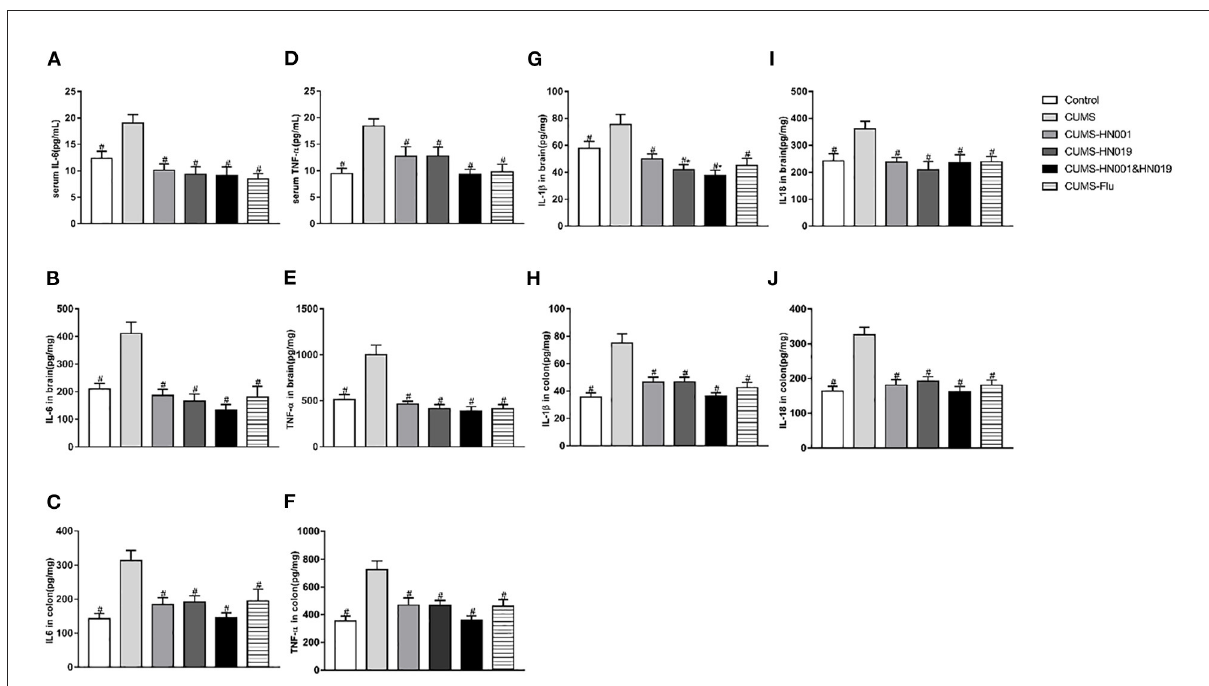
FIGURE5 The levels of IL-6, IL-18, IL-1 β and TNF- α in serum, brain and colon of CUMS rats in different groups during experiment. These indicators were tested at the end of experiment. The results were presented as the Mean ± SEM (simple in serum was 9-10, simple in brain and colon was 6). * p < 0.05 compared with control group. # p < 0.05 compared with CUMS group.